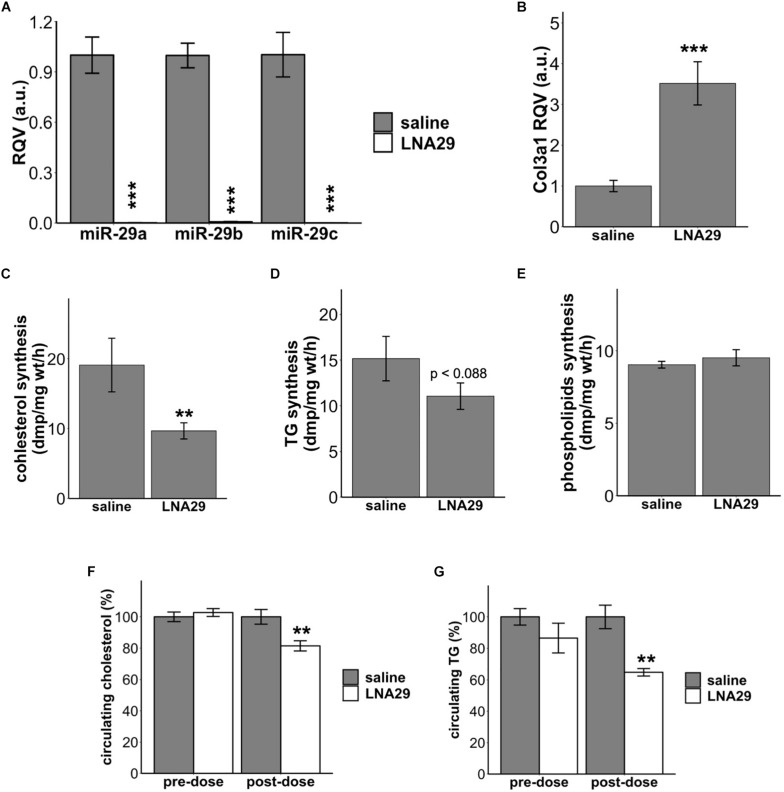
Acute treatment of LNA29 inhibits de novo lipid synthesis in the liver and lowers circulating cholesterol and triglyceride (TG) in chow-fed wild type (WT) mice. (A) RT-qPCR of hepatic miR-29 family of chow-fed WT mice with saline or LNA29 treatment. LNA29 leads to 444, 126, 614 fold suppression in miR-29a, b, and c, respectively. (B) qPCR of Col3a1, a validated miR-29 target gene, of chow-fed WT mice with saline or LNA29 treatment. (C) 3H-acetate incorporation into cholesterol with liver samples harvested from saline- or LNA29-treated WT mice. (D) 3H-acetate incorporation into TG with liver samples harvested from saline- or LNA29-treated WT mice. (E) 3H-acetate incorporation into phospholipids with liver samples harvested from saline- or LNA29-treated WT mice. (F) Non-fasted circulating cholesterol of mice with saline or LNA29 treatment. (G) Non-fasted circulating TG of mice with saline or LNA29 treatment. Given that the circulating data presented in this figure is a repeat of our previous findings, the one-tailed Student’s t-test was used. ∗∗P < 0.01, ∗∗∗P < 0.001 by one-tailed Students’ t test (saline, n = 6; LNA29, n = 6).